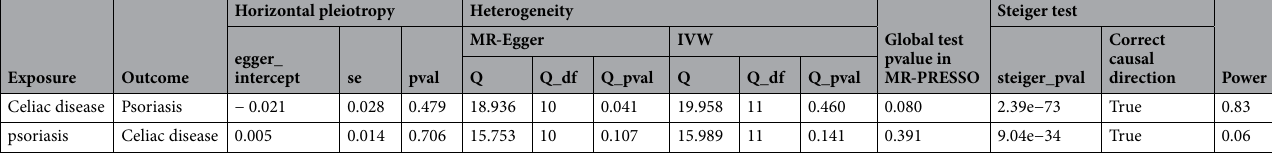
Table 1. Horizontal pleiotropy, heterogeneity, and outlier test for the bidirectional 2-sample MR